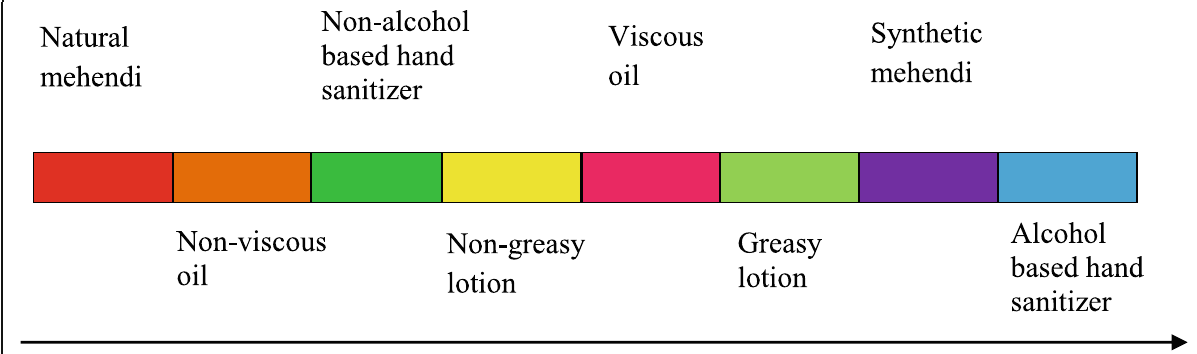
Fig. 5 Visibility percentage of the fingerprint